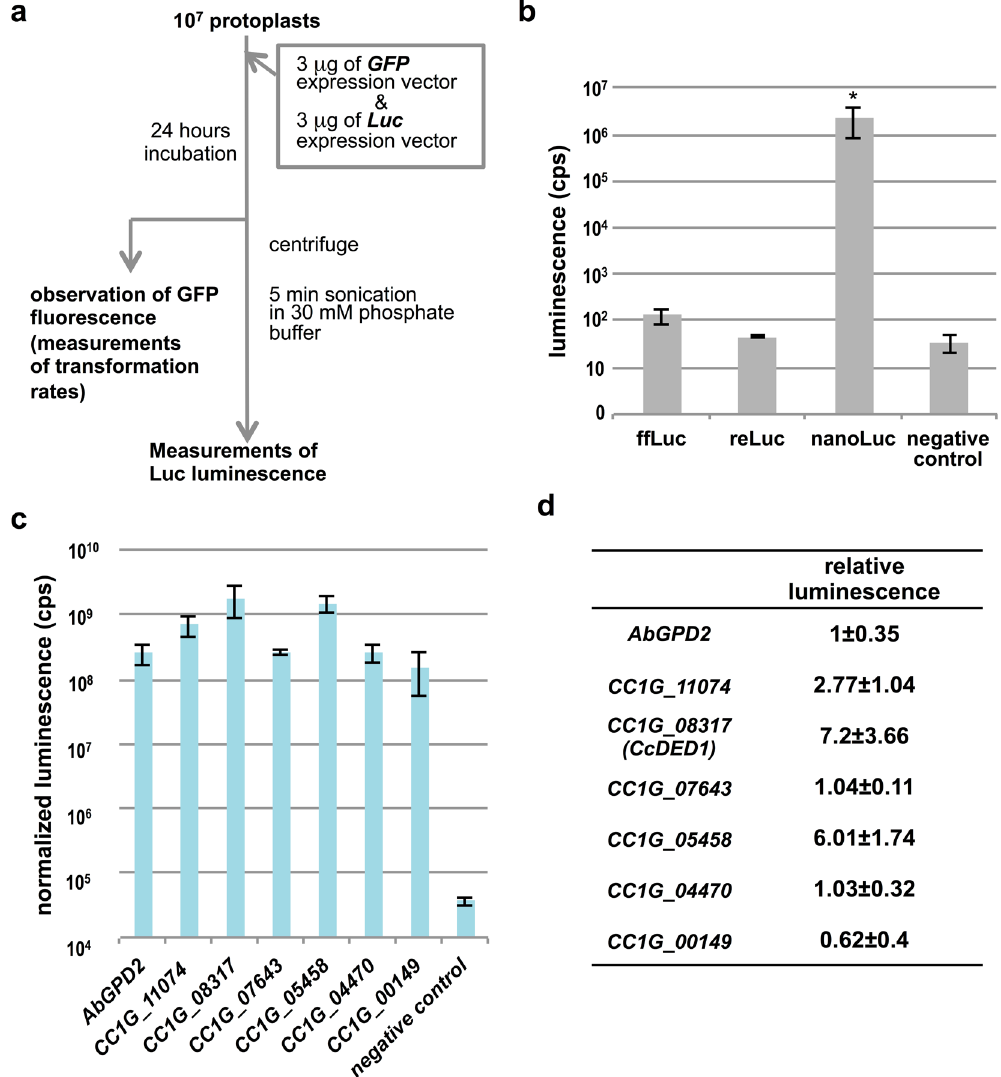
Figure 2. NanoLuc-based luciferase assay using cryopreserved protoplasts identified novel constitutive active promoters in C. cinerea . ( a ) The flow of luciferase assay in C. cinerea , corresponding data are given in Supplementary Fig. 3. ( b ) Comparison of three different luciferases driven by AbGPD2pro . Asterisk shows statistical difference calculated with Turkey’s HSD test ( P < 0.05). ( c ) Comparison of activities of various promoters fused with NanoLuc luciferease. Luminescences of NanoLuc were normalized by transformation rate. Bars: S.D., n = 3. ( d ) Relative luminescence results of the experiments shown in ( c ), with the luminescence of AbGPD2pro defined as 1. Number ±